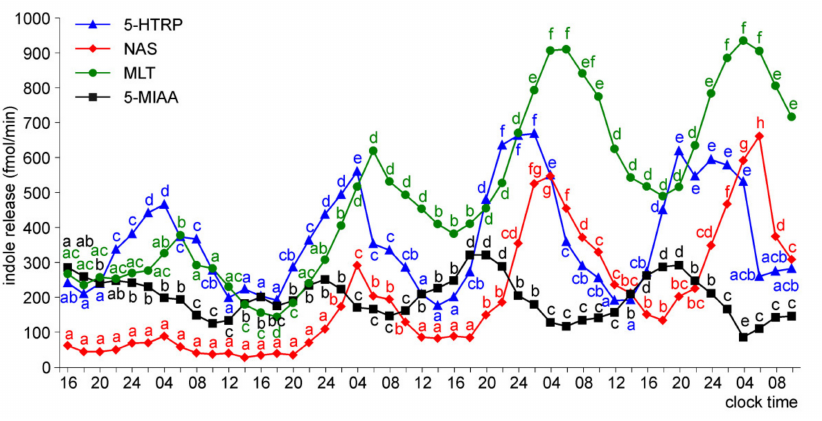
Figure 8. Release of 5-HTRP, NAS, MLT, and 5-MIAA (means, n = 3) from pineal organs of ED 24 embryos incubated under a 12L:12D cycle. The same letters indicate means, which are not significantly different between